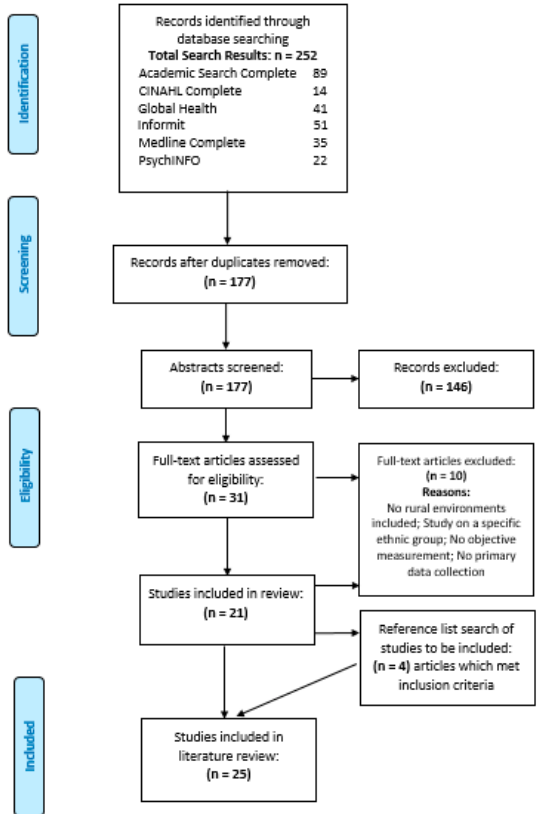
Figure 2. PRISMA diagram of literature search.